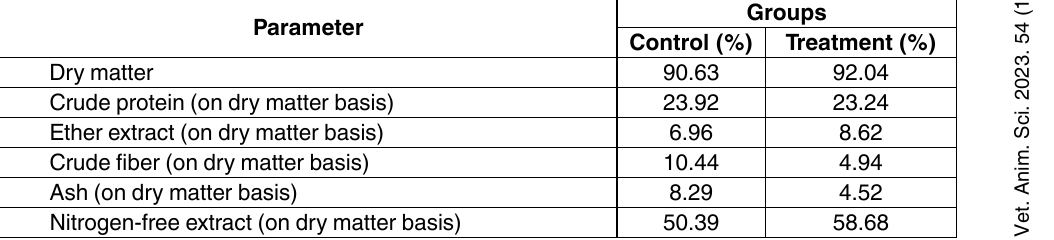
table 3. Proximate composition of the diets of experimental